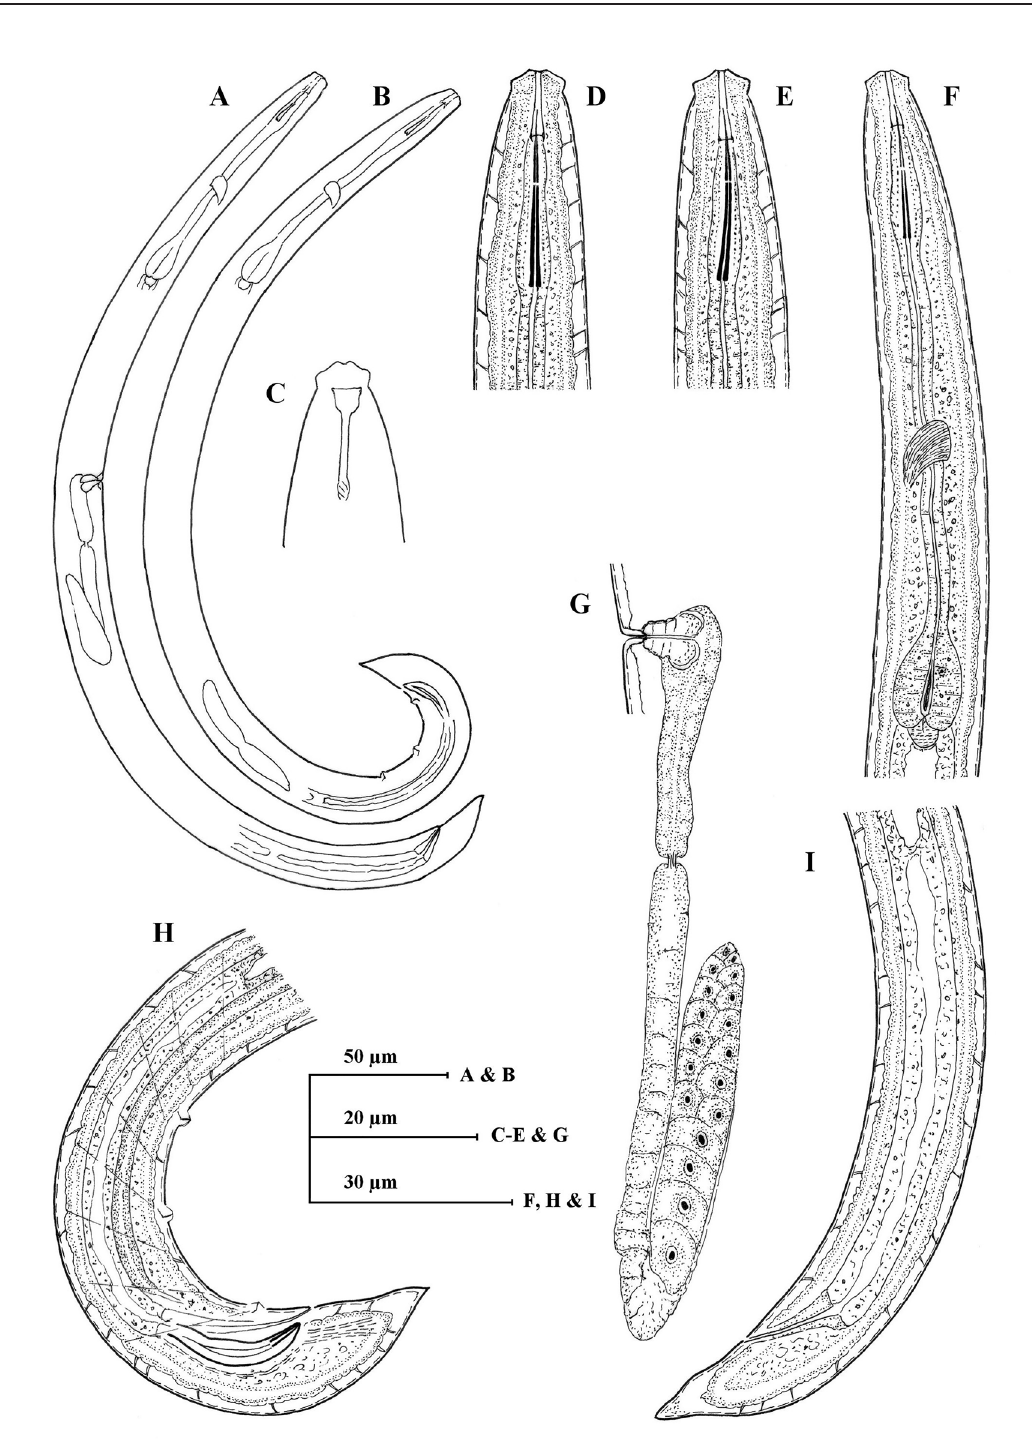
Fig. 14. Basirotyleptus neocaudatus sp. nov. A, C, E–F, I . Holotype, ♀ (AMU/ZD/NC/ Basirotyleptus neocaudatus /1). B, H . Paratype, ♂ (AMU/ZD/NC/ Basirotyleptus neocaudatus /4). D . Specimen 10, ♀ (AMU/ZD/NC/ Basirotyleptus neocaudatus /6). G . Paratype 1, ♀ (AMU/ZD/NC/ Basirotyleptus neocaudatus /2). A . Entire female. B . Entire male. C . Female, anterior region showing amphid. D–E . Female, anterior region. F . Female, pharyngeal region. G . Female, genital system. H . Male, posterior region. I . Female, posterior